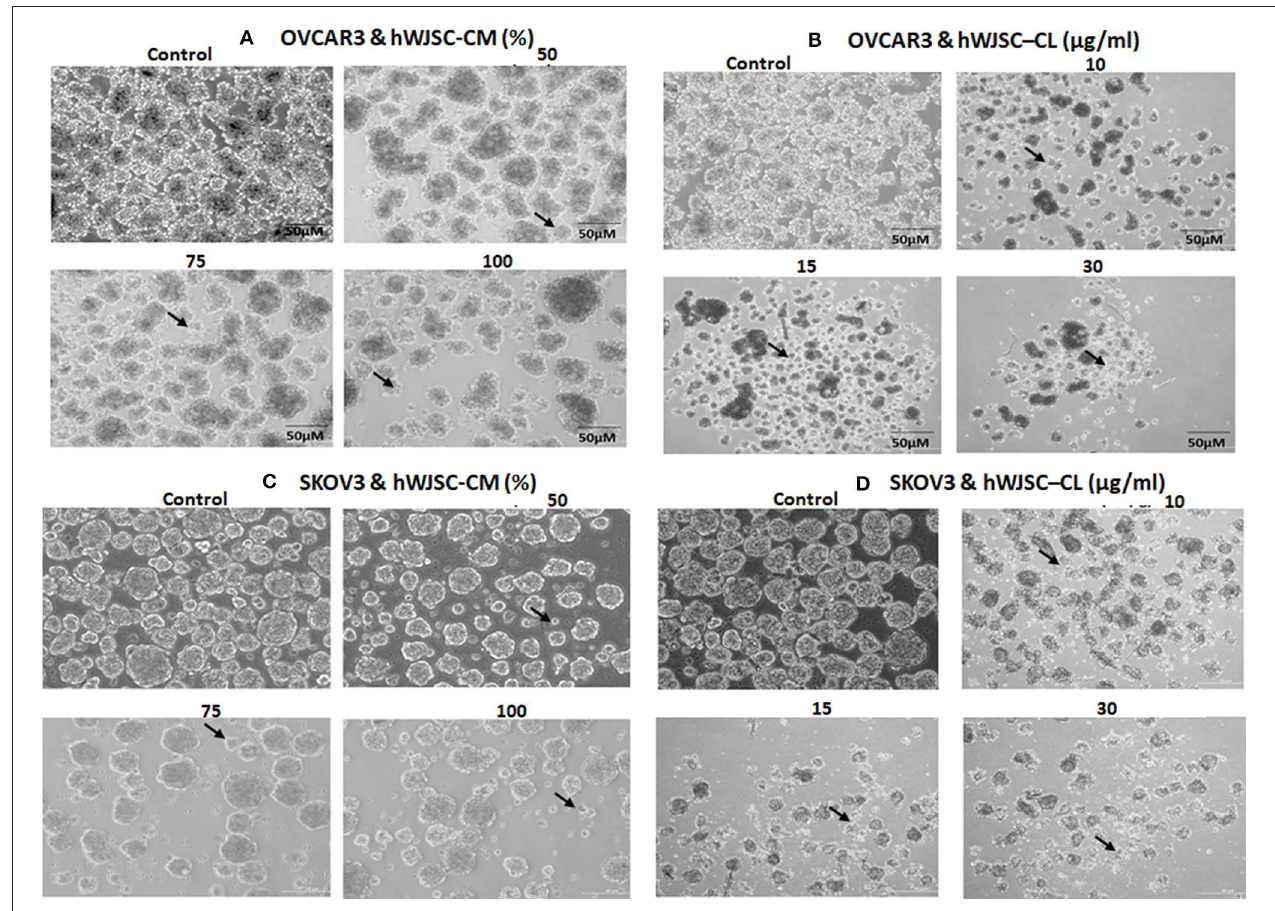
FIGURE 8 | Representative phase contrast images of the tumor spheres (TS) of (A) OVCAR3 treated with hWJSC-CM; (B) TS of OVCAR3 treated with hWJSC-CL; (C) TS of SKOV3 treated with hWJSC-CM and (D) TS of SKOV3 treated with hWJSC-CL. Decrease in TS size, numbers and cell death/degeneration (indicated by thin black arrows) were more evident following treatment with hWJSC-CL (10, 15, and 30 µ g/ml) than with hWJSC-CM (50, 75, and 100%) for